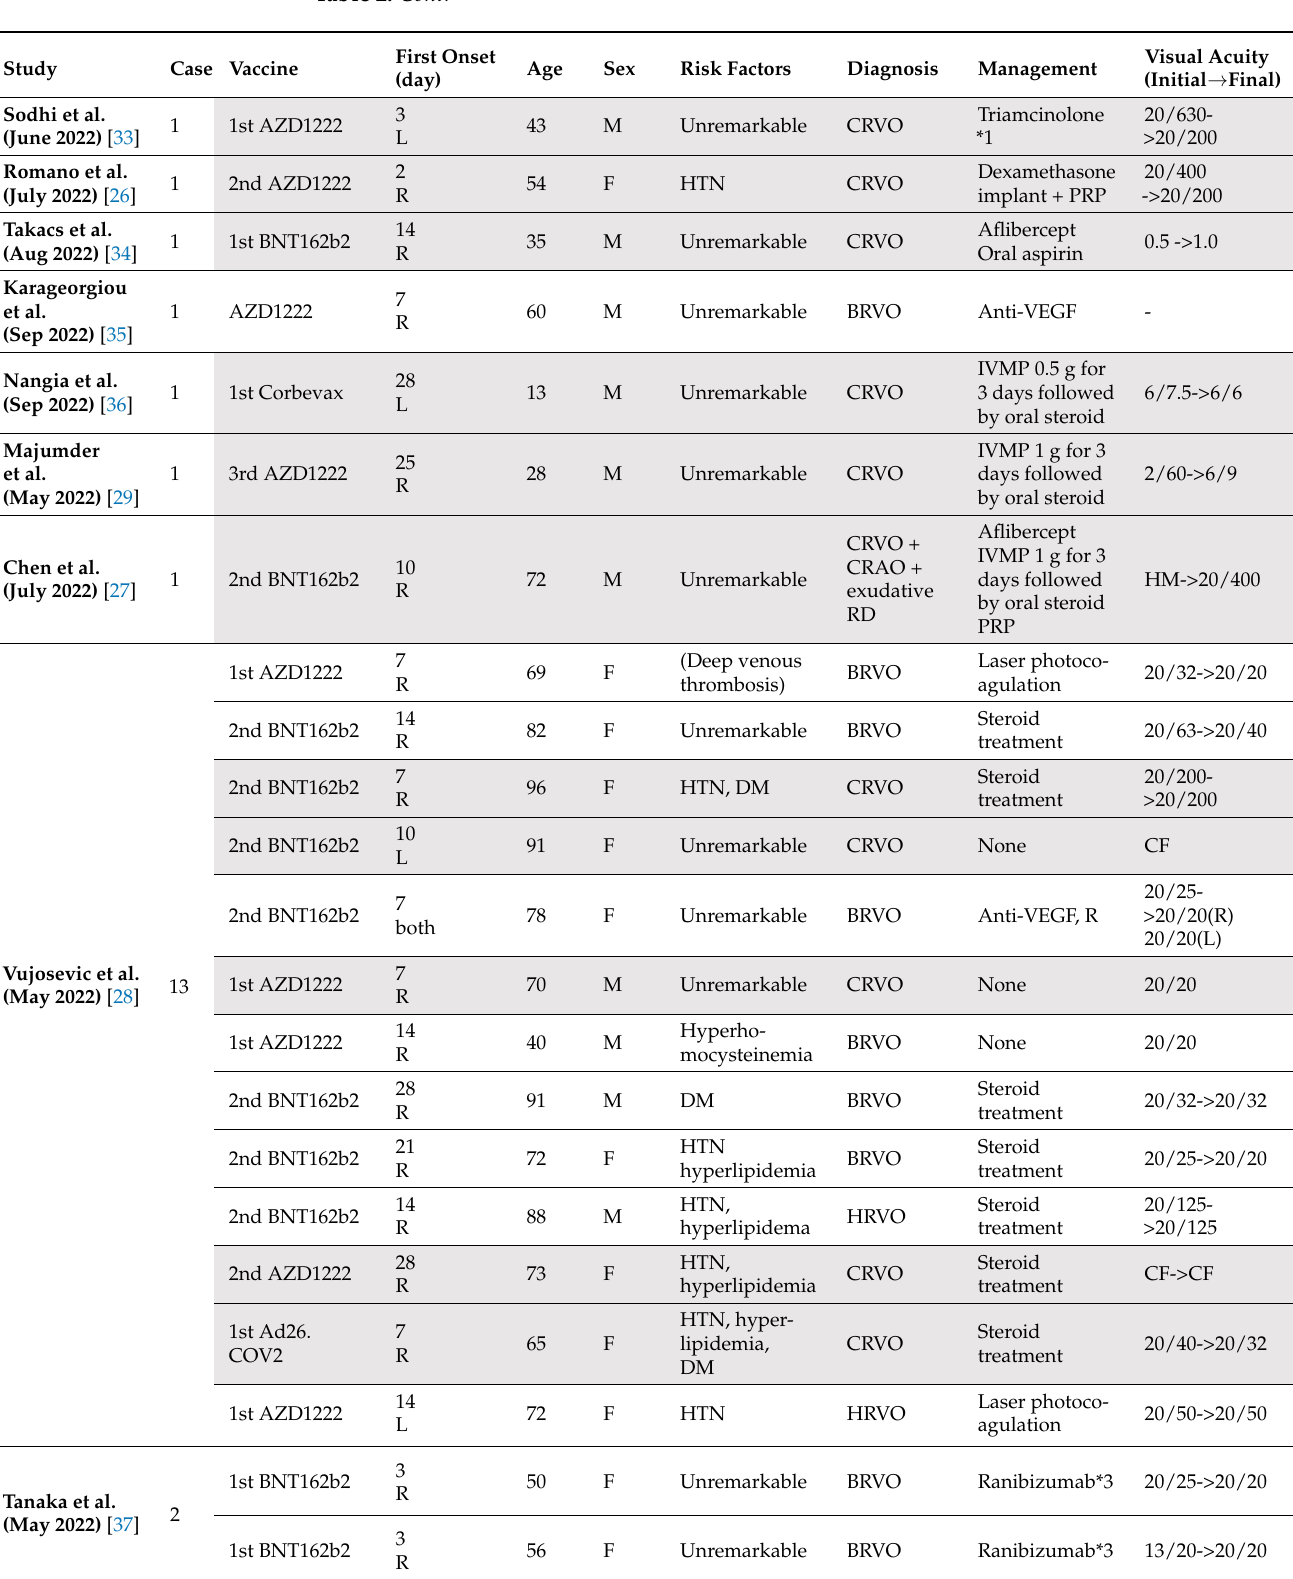
Abbreviations: HTN: hypertension, F: female, M: male, R: right eye, L: left eye, both: both eyes, BRVO: branch retinal vein occlusion, CRVO: central retinal vein occlusion, CRAO: central retinal artery occlusion, HRVO: hemi